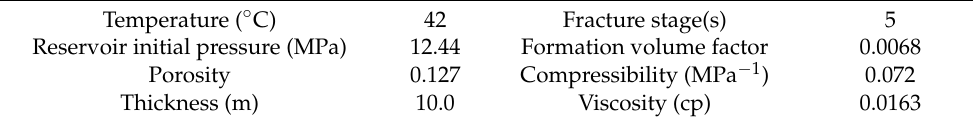
Figure 4. Daily production dynamics of the MHFHW Y-9-1H. Table 2. Basic parameters of the reservoir and the MHFHW